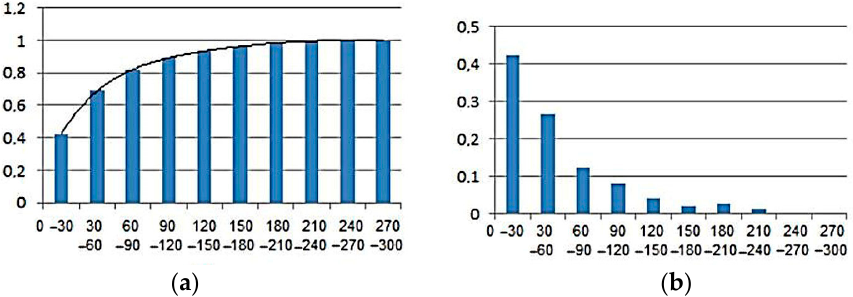
Figure 21. Statistical treatment of maximum braking power: ( a ) integral distribution, ( b ) probability density function.